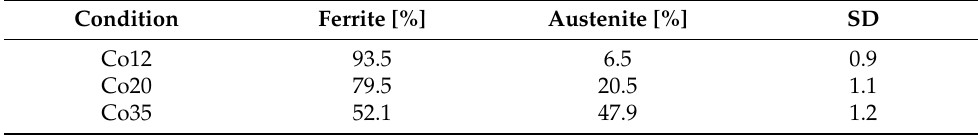
Table 4. Weld bead